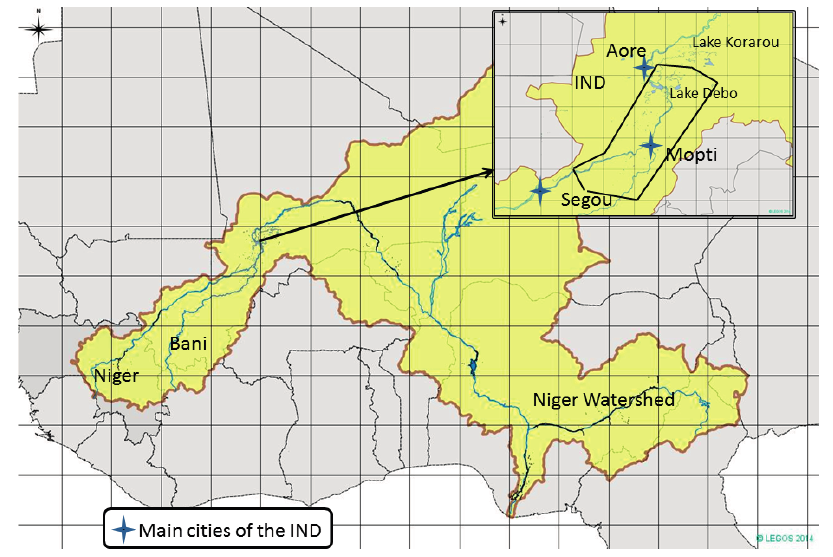
Figure 1. Map of the Niger River watershed (yellow) and Inner Niger Delta (IND) (zoom). Black lines represent country